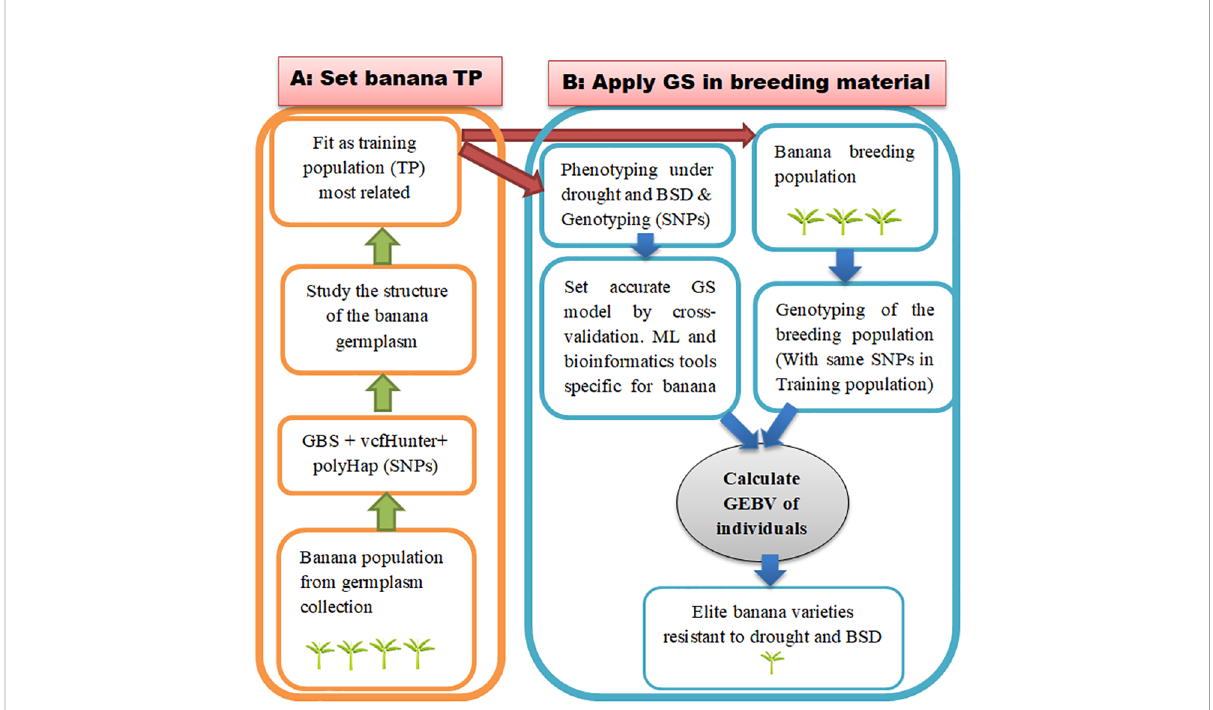
FIGURE 6 Application diagram of GS on banana population from germplasm collection for drought and for BSD. (A) Set a training population from germplasm collection. This involves selecting the most related individuals in the population and using them as training population (B) Design an accurate GS model by cross-validation using data from genotyping and from phenotyping for drought and BSD and then implement GS on banana breeding material. This involves calculating the genetic values of individual candidate to selection (breeding material) using the most accurate model. TP, training